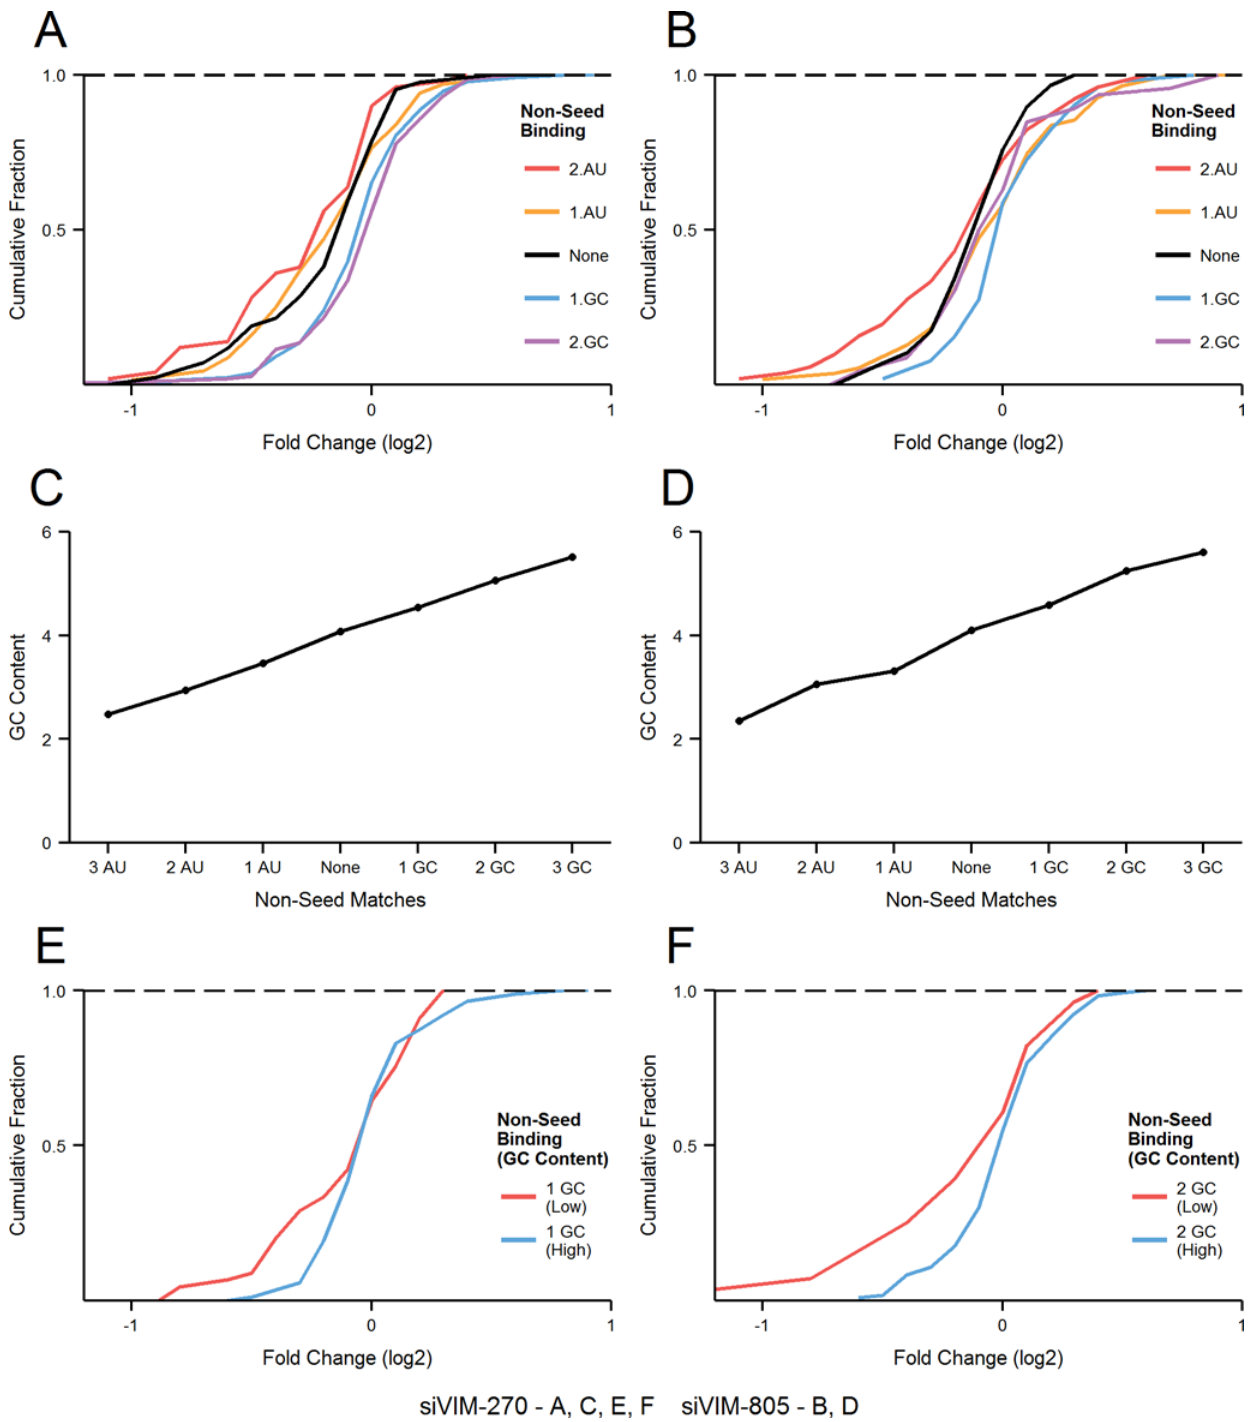
Fig 4. Analysis of off-target effects based on sequence similarity between an siRNA non-seed region and its corresponding target sequences. (A, B) Cumulative distribution of off-target transcripts grouped by their non-seed base-pairing (Fig 4A; siVIM-270 off-target effects, 2AU (70), 1AU (52), None (27), 1GC (133), 2GC (151), Fig 4B; siVIM-805 off-target effects, 2AU (55), 1AU (52), None (20), 1GC (52), 2GC (46)). Off-target transcripts with more than 2AU or 2GC match were omitted due to their low number. (C, D) The average GC contents for non-seed region (positions 8 – 15) were calculated for each group of off-target transcripts. (E, F) The cumulative distribution of off-target transcripts of siVIM-270 with 1GC match (133 transcripts)(E) and 2GC matches (151 transcripts)(F), were sub-divided based on their GC contents at positions 8 – 15. ‘ Low ’ subgroups have GC content lower than the average while ‘ High ’ subgroups have GC content higher than the